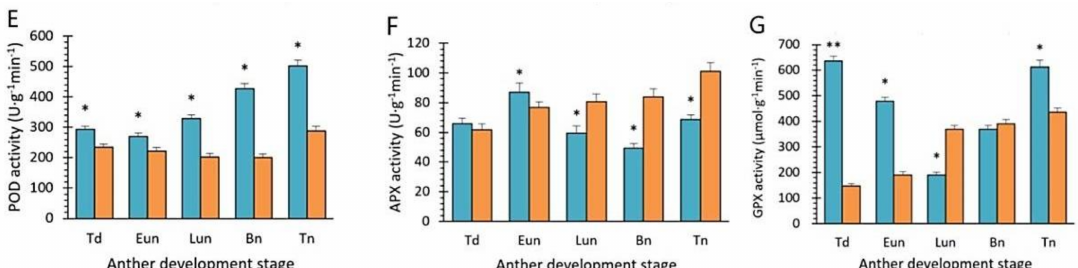
Figure 8. Nonenzymatic antioxidant contents ( A , B ) and activities of antioxidant enzymes ( C – G ) in anthers from U87B1-706A and 706B during different developmental stages. Td, tetrad stage; Eun, early uninucleate stage; Lun, late uninucleate stage; Bn, binucleate stage; and Tn, trinucleate stage. ( A ) AsA contents; ( B ) GSH contents; ( C ) SOD activity; ( D ) CAT activity; ( E ) POD activity; ( F ) APX activity;